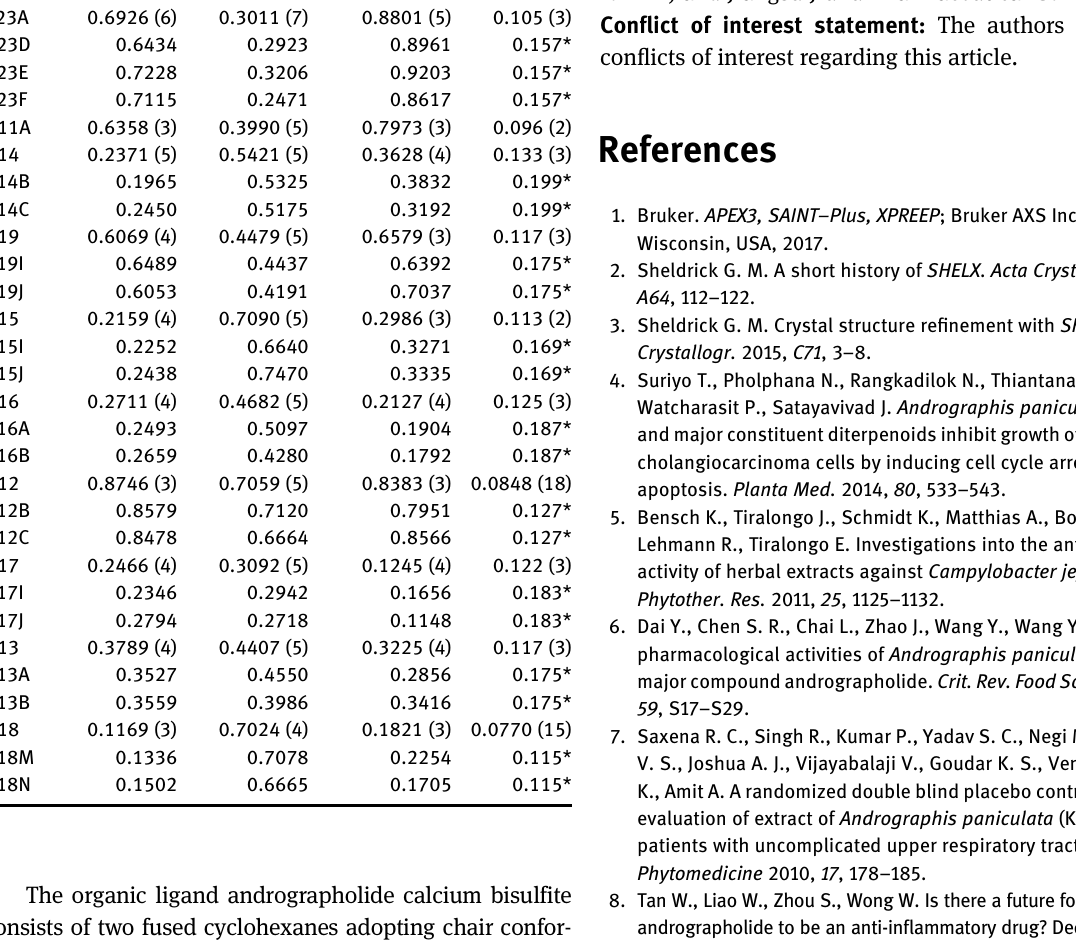
The organic ligand andrographolide calcium bisulfite consists of two fused cyclohexanes adopting chair confor- mations and a nearly planar five-membered lactonic